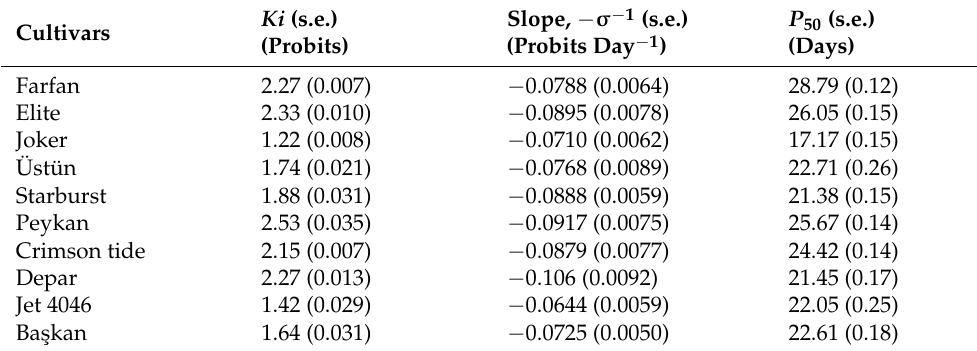
Table 2. Probit model parameters for seed cultivars of ten hybrid watermelon seed cultivars aged with 17% seed moisture content over 63 days.